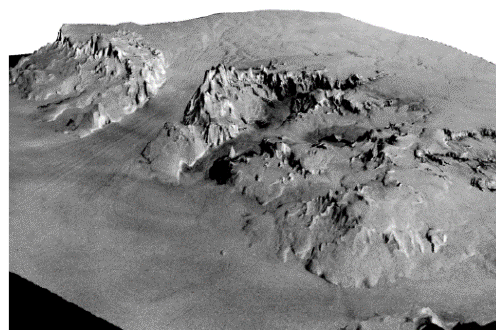
Figure 5. 3D view of the ARGON orthophoto draped on the DTM in the Byrd glacier